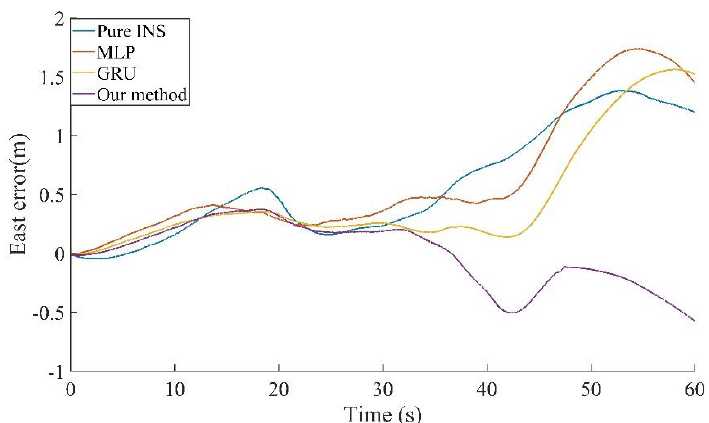
Figure 8. The east position error result of 60 s outage of Experiment 1.